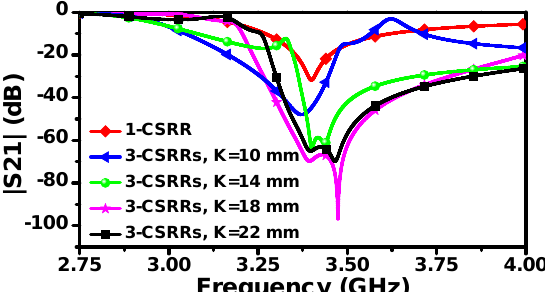
Figure 3. The scattering parameter | S 21 | of a single CSRR and three identical-coupled CSRRs with different values of K.